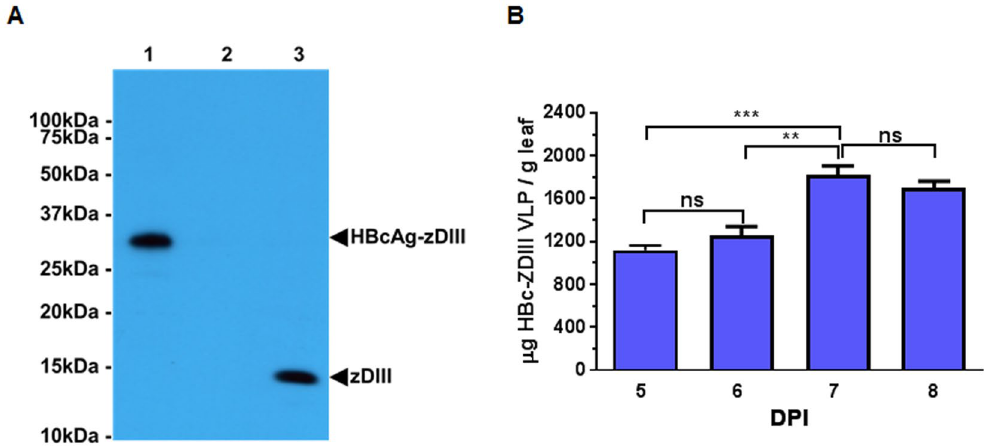
Figure 2. Western blot and ELISA analysis of HBcAg-zDIII. Total proteins from HBcAg-zDIII construct- infiltrated N. benthamiana leaves were isolated on days 5 to 8 post agroinfiltration (DPI). ( A ) Samples from 7 DPI were separated on 12% SDS-PAGE gels under reducing conditions and blotted onto PVDF membranes. The membranes were incubated with a mouse anti-zDIII antibody to detect the HBcAg-zDIII fusion protein. Lane 1, Extract from leaves infiltrated with HBcAg-zDIII construct (10 µ g total protein); lane 2, Extracted from un-infiltrated leaves as a negative control (10 µ g total protein); lane 3, zDIII positive control (1 µ g). The full- length blot is presented in Supplementary Fig. S1. ( B ) Protein extracts were analyzed with an ELISA that detects HBcAg-zDIII. Mean ± standard deviation (SD) of samples from three independent infiltration experiments are presented. *** and ** indicate p values = 0.0002 and 0.0012 of HBcAg-zDIII expression levels at 7 DPI compared to that of 5 and 6 DPI, respectively. ns = no statistically significant different (p >